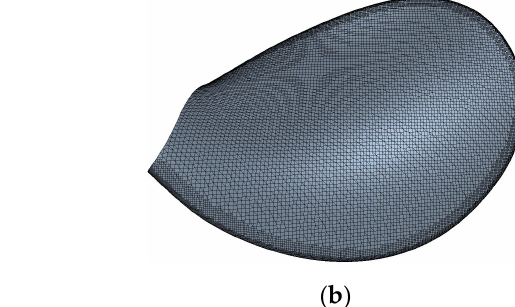
Figure 2. Mesh characteristics: ( a ) whole computational domain and ( b ) blade surface.